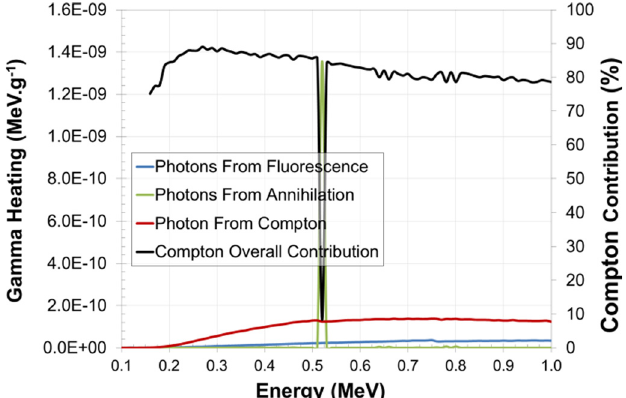
Fig. 9. Photonic spectrum taken at the internal and external gamma shield